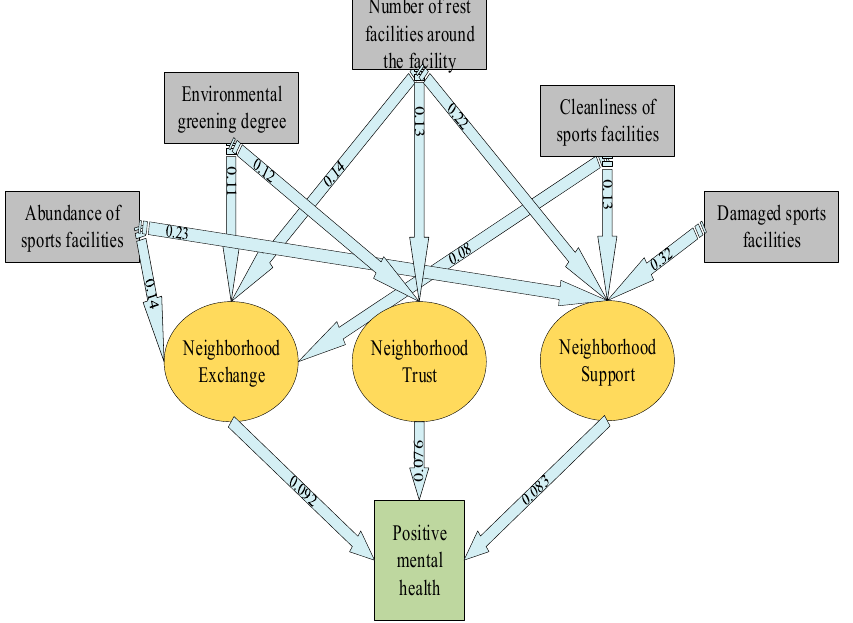
Figure 7. The situation in which social environment characteristics play mediating role in the im- pact of the physical environment on mental health. of the physical environment on mental